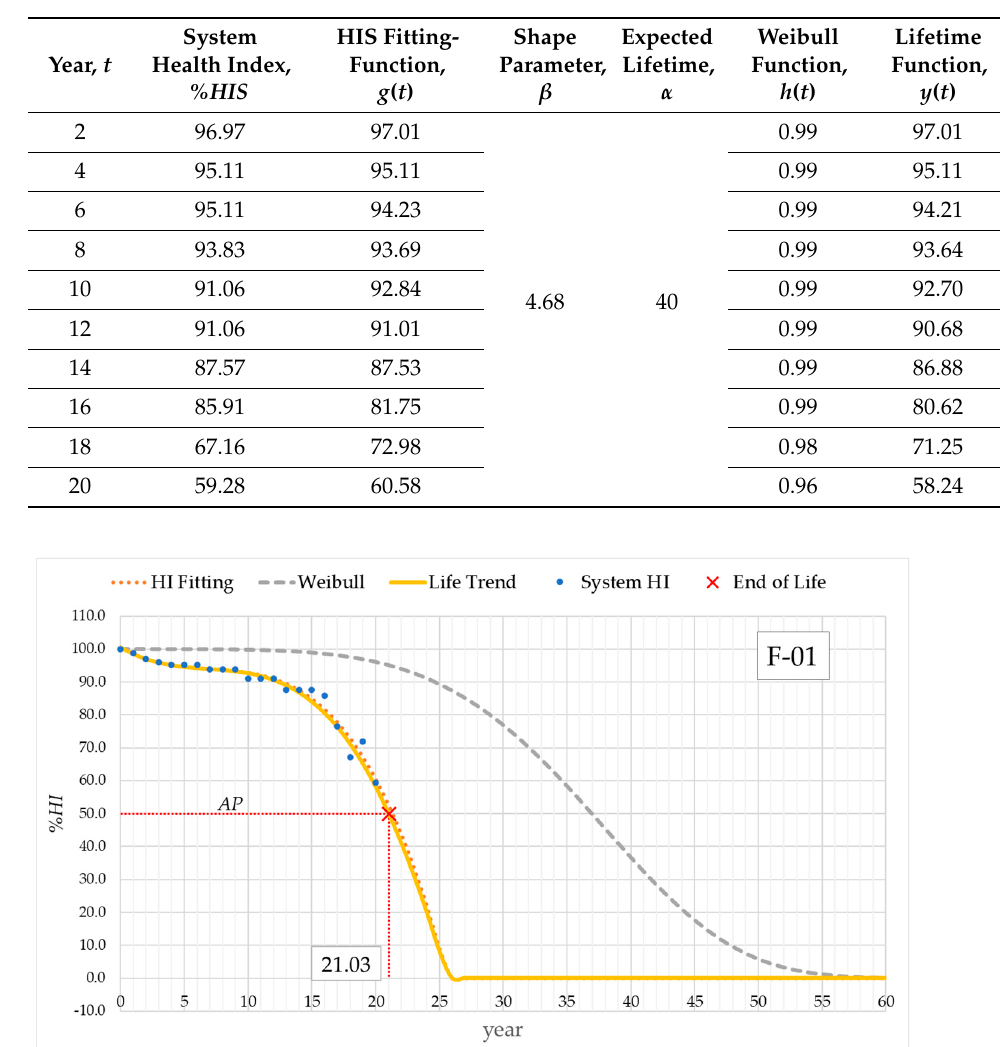
Figure 7. Plot of predictive health index multiplied by conditional factor for lifetime estimation of cable feeder F-01.